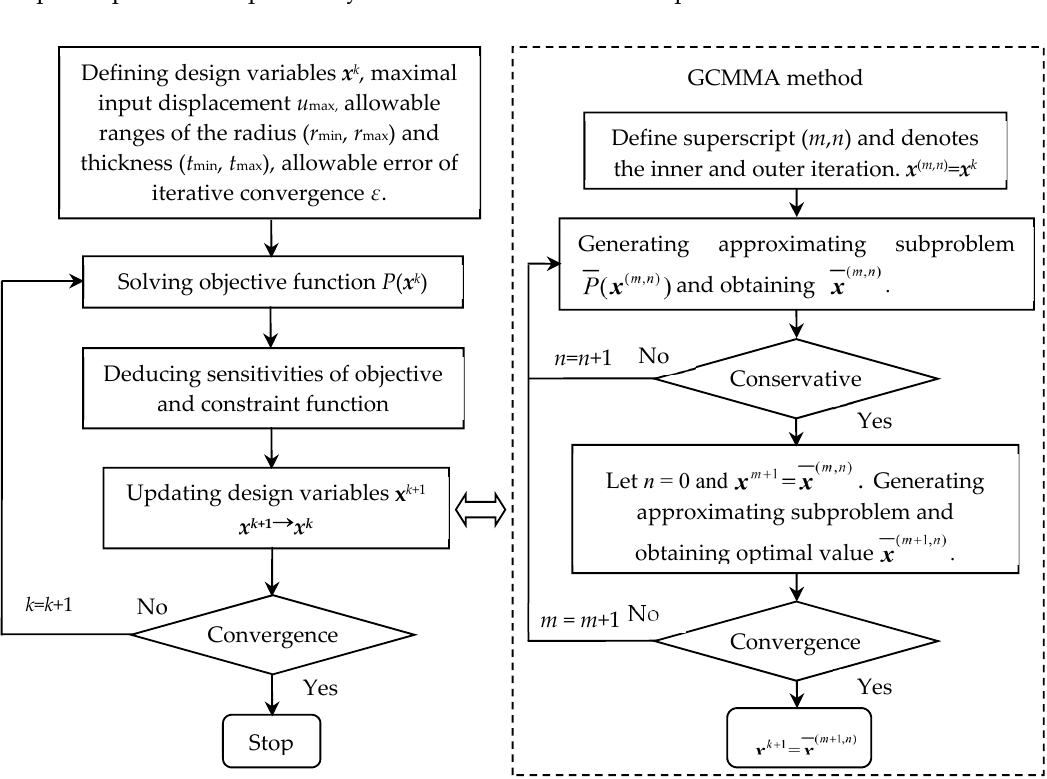
Figure 4. The solution flowchart of the optimization problem.